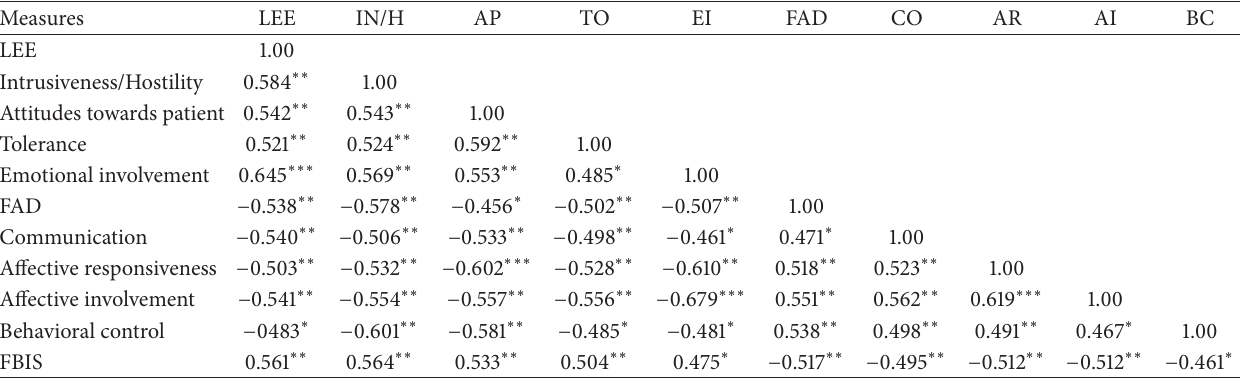
Table 5: Pearson’s correlations between the LEE scale and other theoretically relevant measures ( 𝑁 = 262